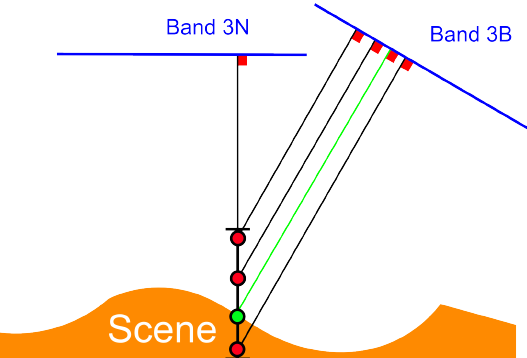
Figure 5: Search for the altitude yielding the best correlation for a given